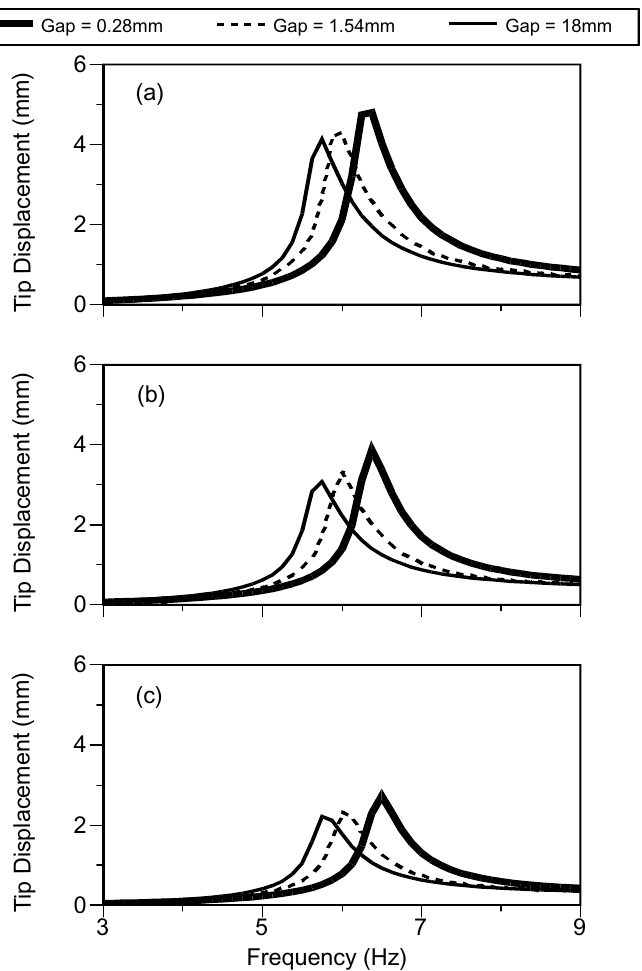
Fig. 5. Frequency response of beam tip at different gaps when magnets are arranged in repulsion for base displacement: (a) 0.23 mm, (b) 0.17 mm and (c) 0.11